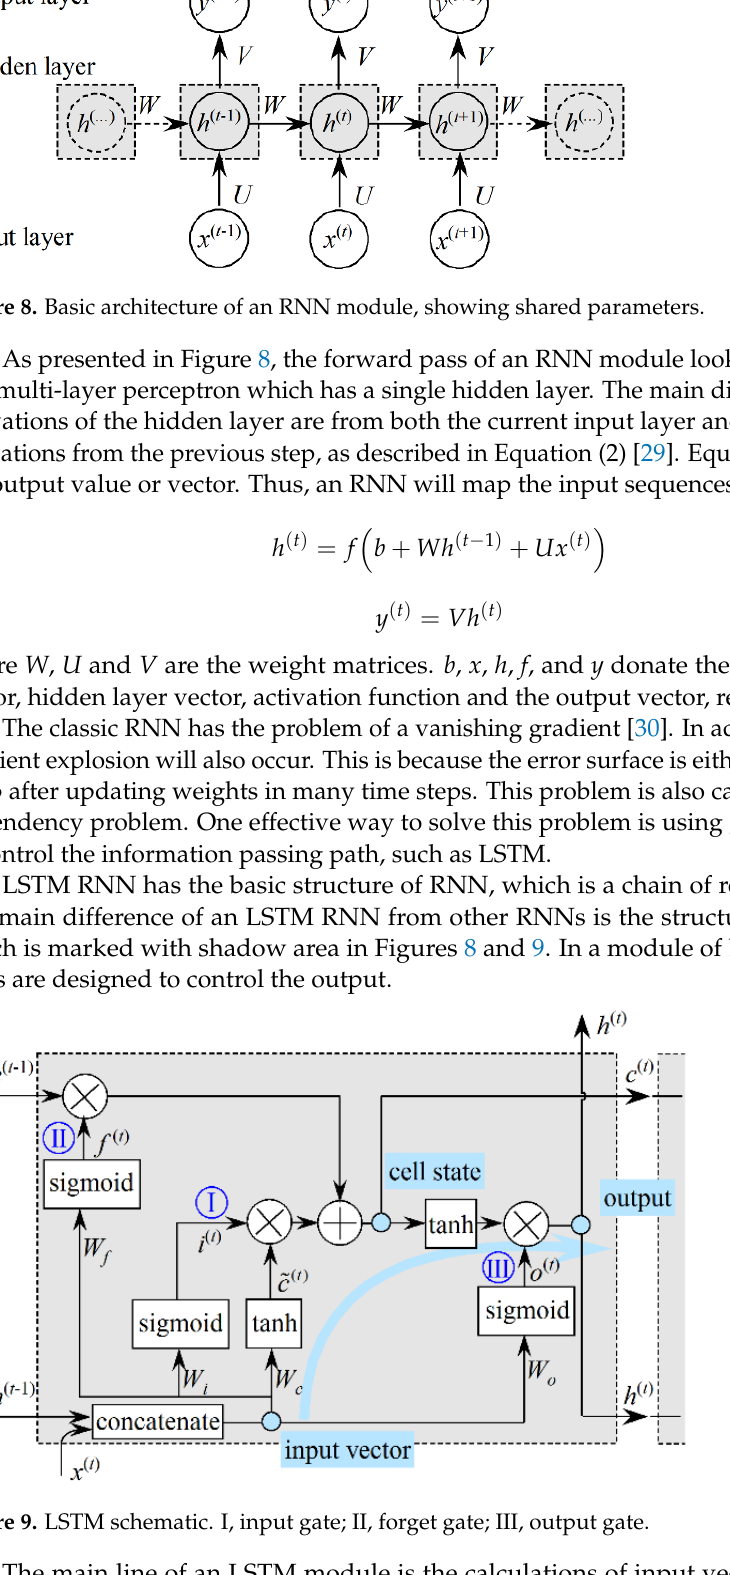
Figure 9. LSTM schematic. I, input gate; II, forget gate; III, output gate.